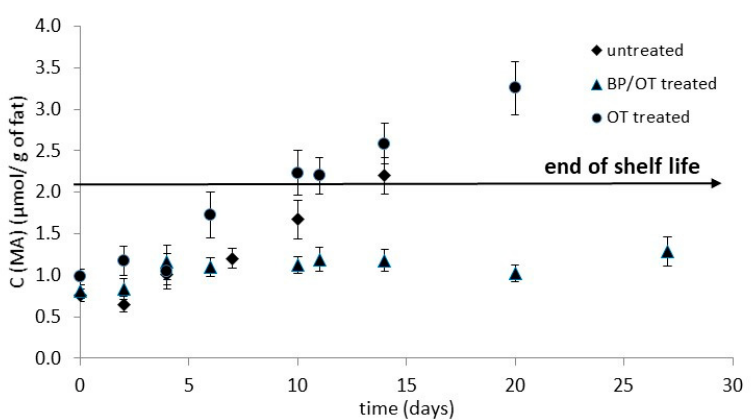
Figure 5. Lipid oxidation of fish fillets (expressed as concentration of malondialdehyde, µmol MDA/g of fat) during storage at 5 °C. Error bars represent the ± standard deviation of measurements.